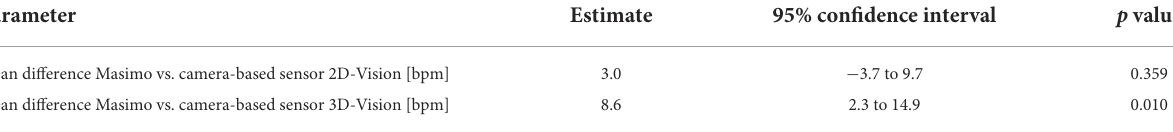
TABLE 2 Mean difference in heart rate in beats per min comparing Masimo vs. camera-based sensor. Parameter